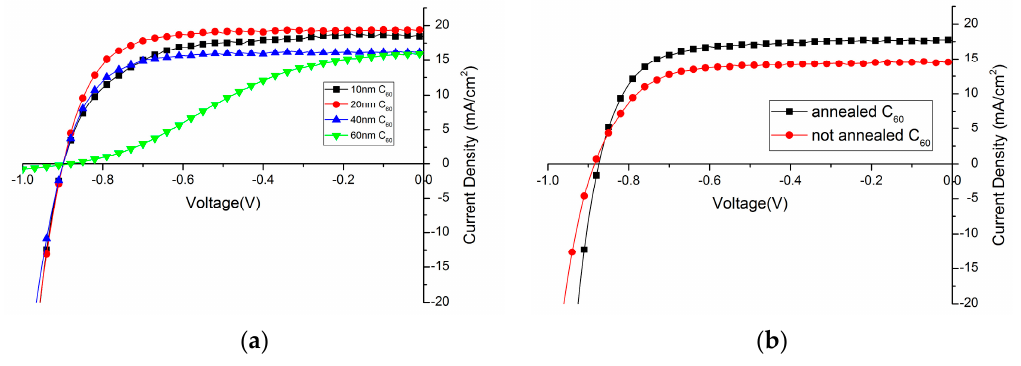
Figure 4. Influence of C 60 layer ( a ) thickness; and ( b ) annealing effect on device performance. Table 1. Effect of C60 layer thickness on device performance.